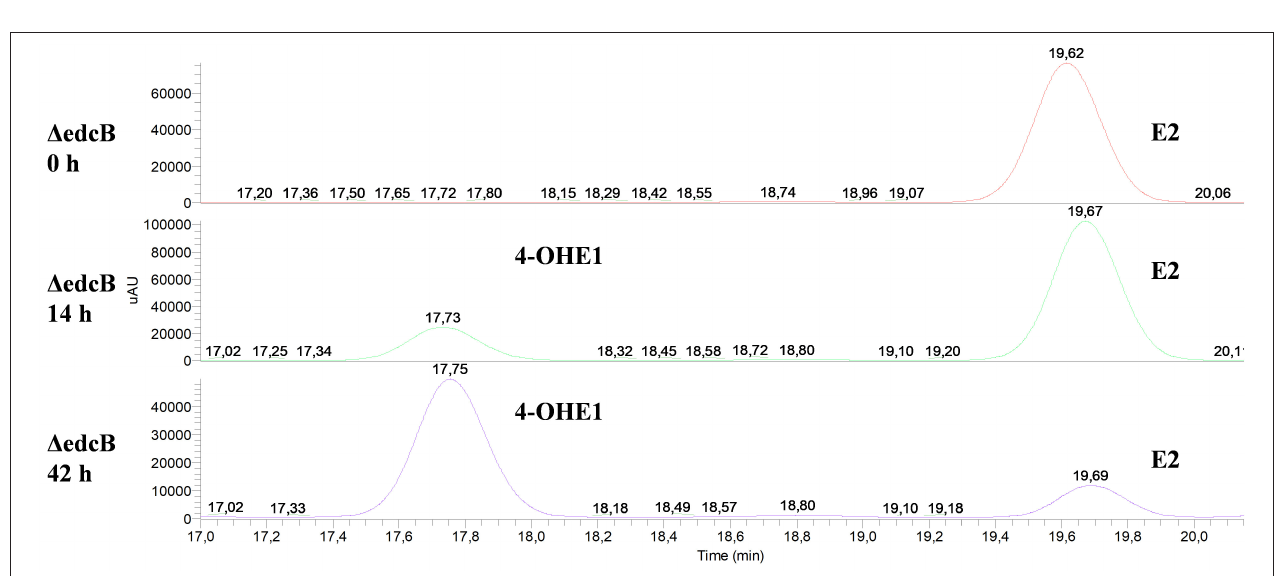
FIGURE 7 | HPLC-MS analysis of the organic phase extracted from cultures from N. tardaugens 1 Prom (pSEVA23PlexA) and N. tardaugens 1 Prom (pSEVA23edcA) growing on NB rich medium supplemented with 2mM E2. UV chromatograms at 282nm of the samples at 47h.